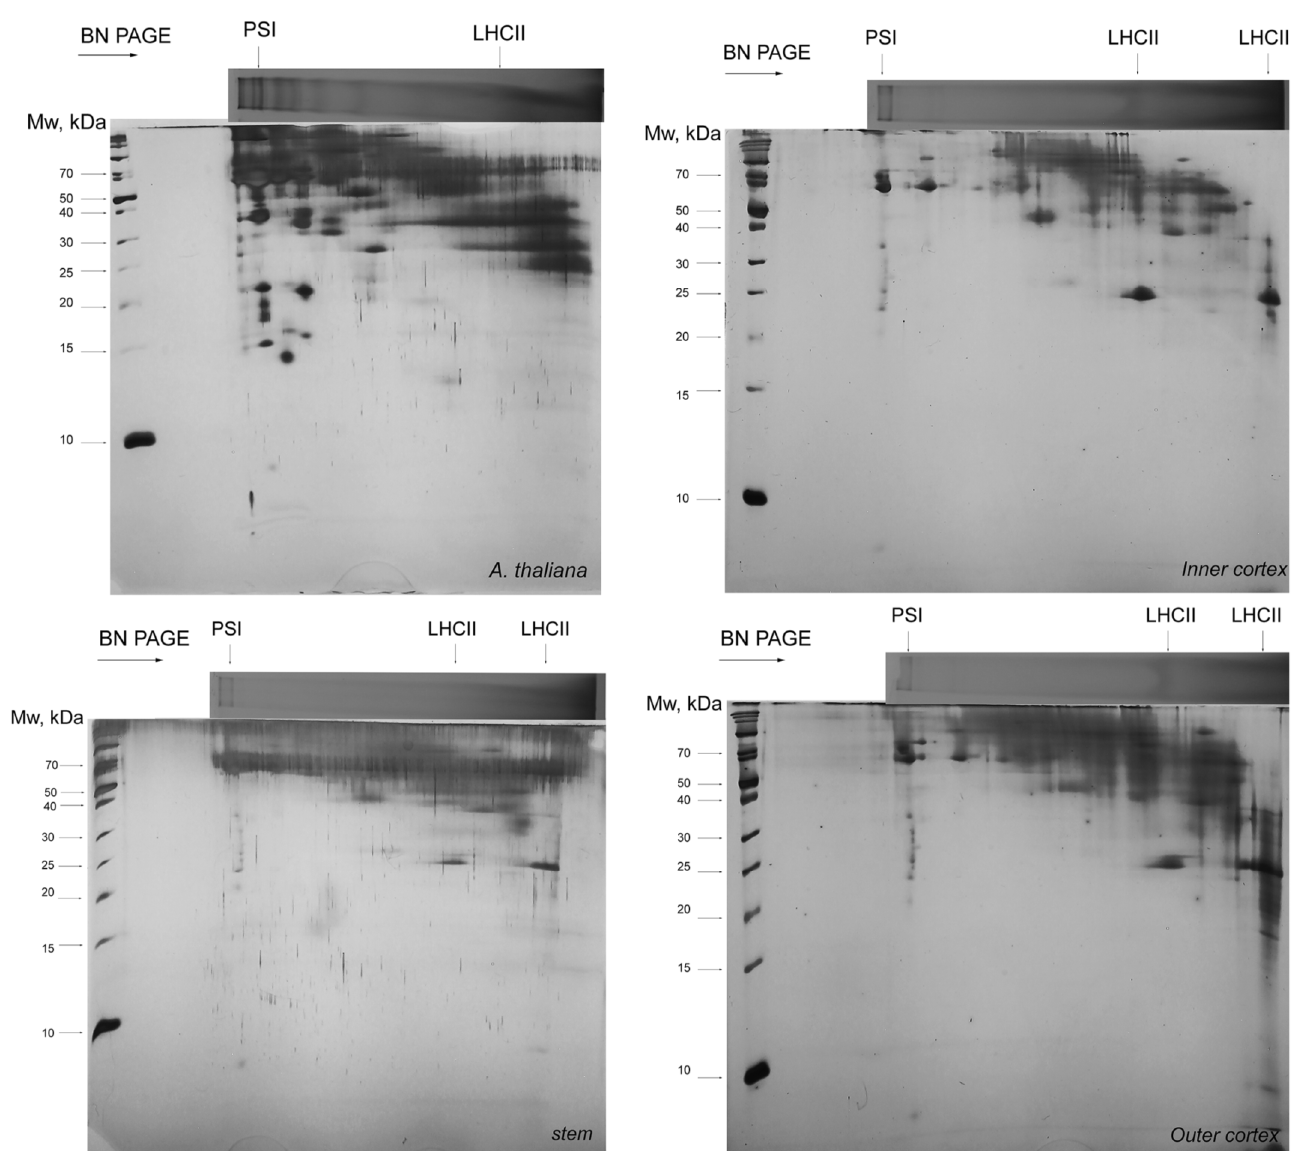
Figure 6. 2D BN/SDS PAGE separation of thylakoid complexes in Arabidopsis thaliana , Cuscuta campestris stem, and Smicronyx galls (inner and outer cortex, respectively). Solubilization with 1% digitonin. Only the low-molecular-weight standards are indicated.